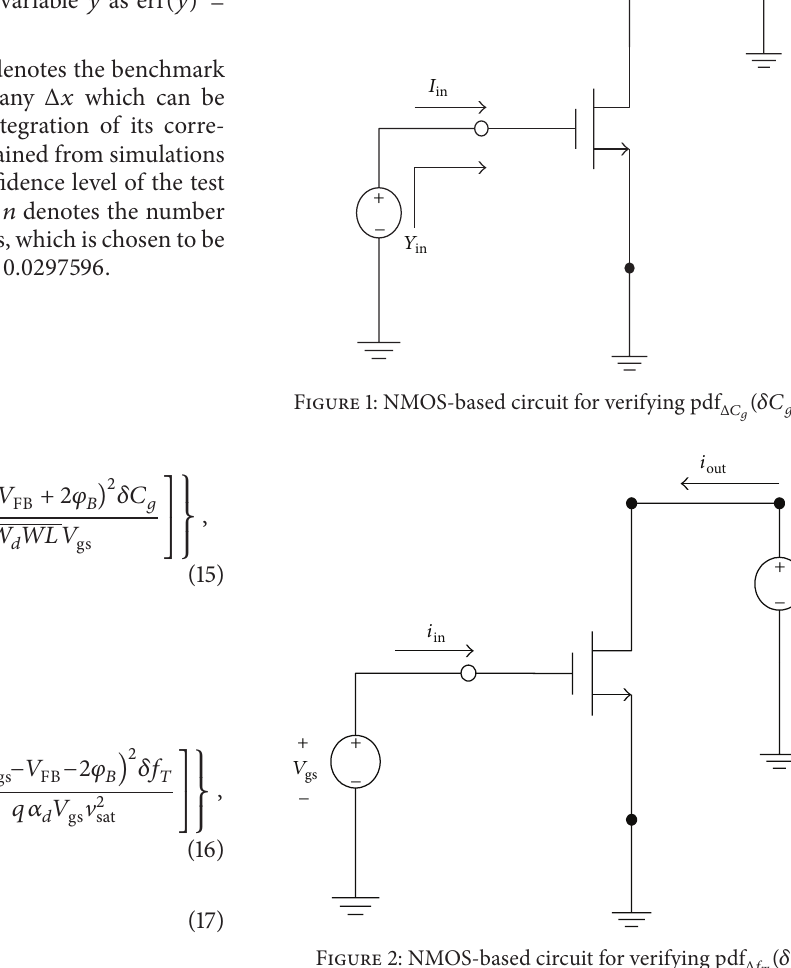
Figure 2: NMOS-based circuit for verifying pdf Δ𝑓 for verification of pdf Δ𝐶